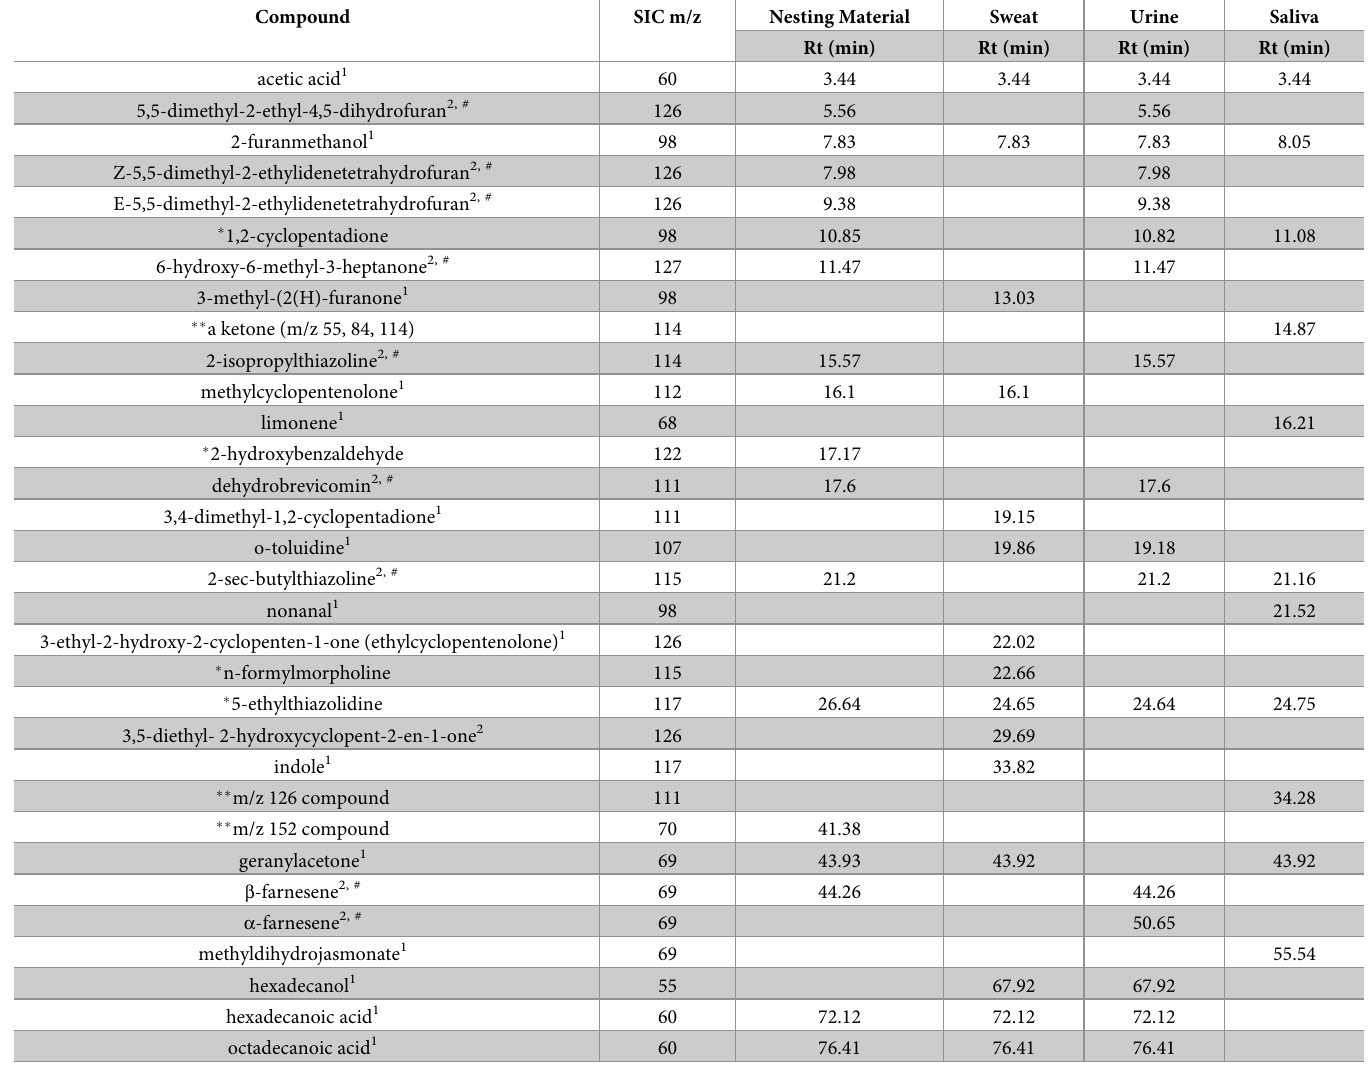
Table 1. List of identified compounds across sample type in order of ascending run